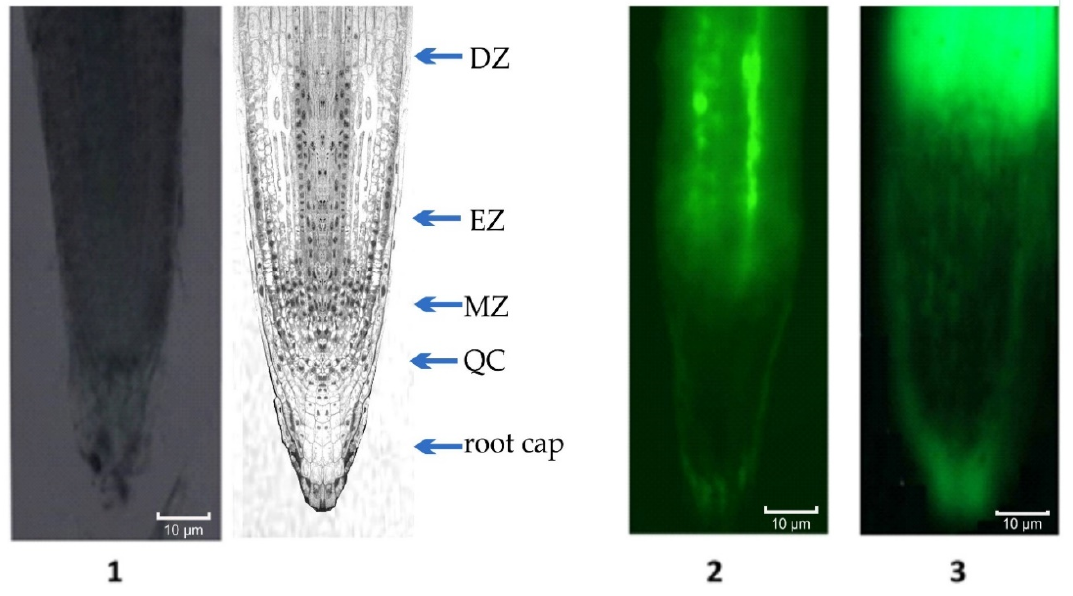
Figure 2. Visualization of FITC-labeled AEDL in tobacco roots. ( 1 ) Root incubated with FITC; ( 2 ) root incubated with FITC-AEDL; ( 3 ) root incubated with FITC-AEDL with 3× magnification of MZ. DZ—zone of differentiation; EZ—elongation zone; MZ—meristematic zone; QC—quiescent center.